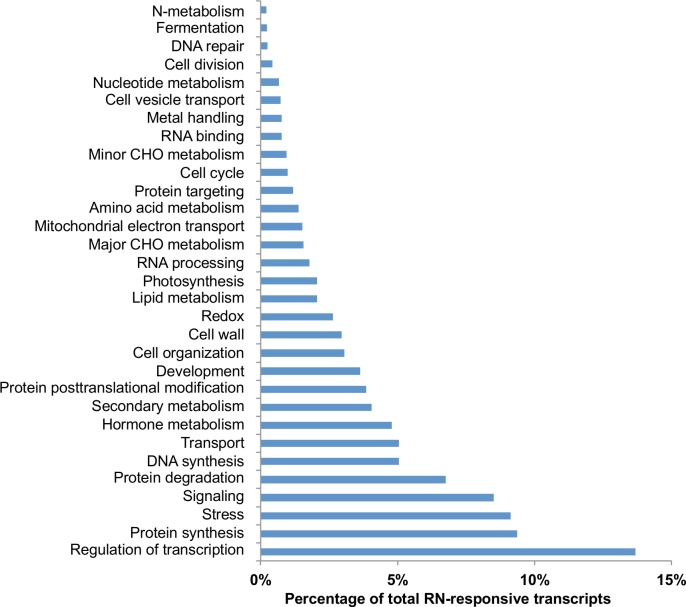
Gene Ontology categories of R. reniformis-responsive transcripts.The percentage of R. reniformis-responsive transcripts in each biological pathway category is shown. A transcript was considered R. reniformis-responsive if the FDR corrected P-value is smaller than 0.01 and the fold change value is more than 2.